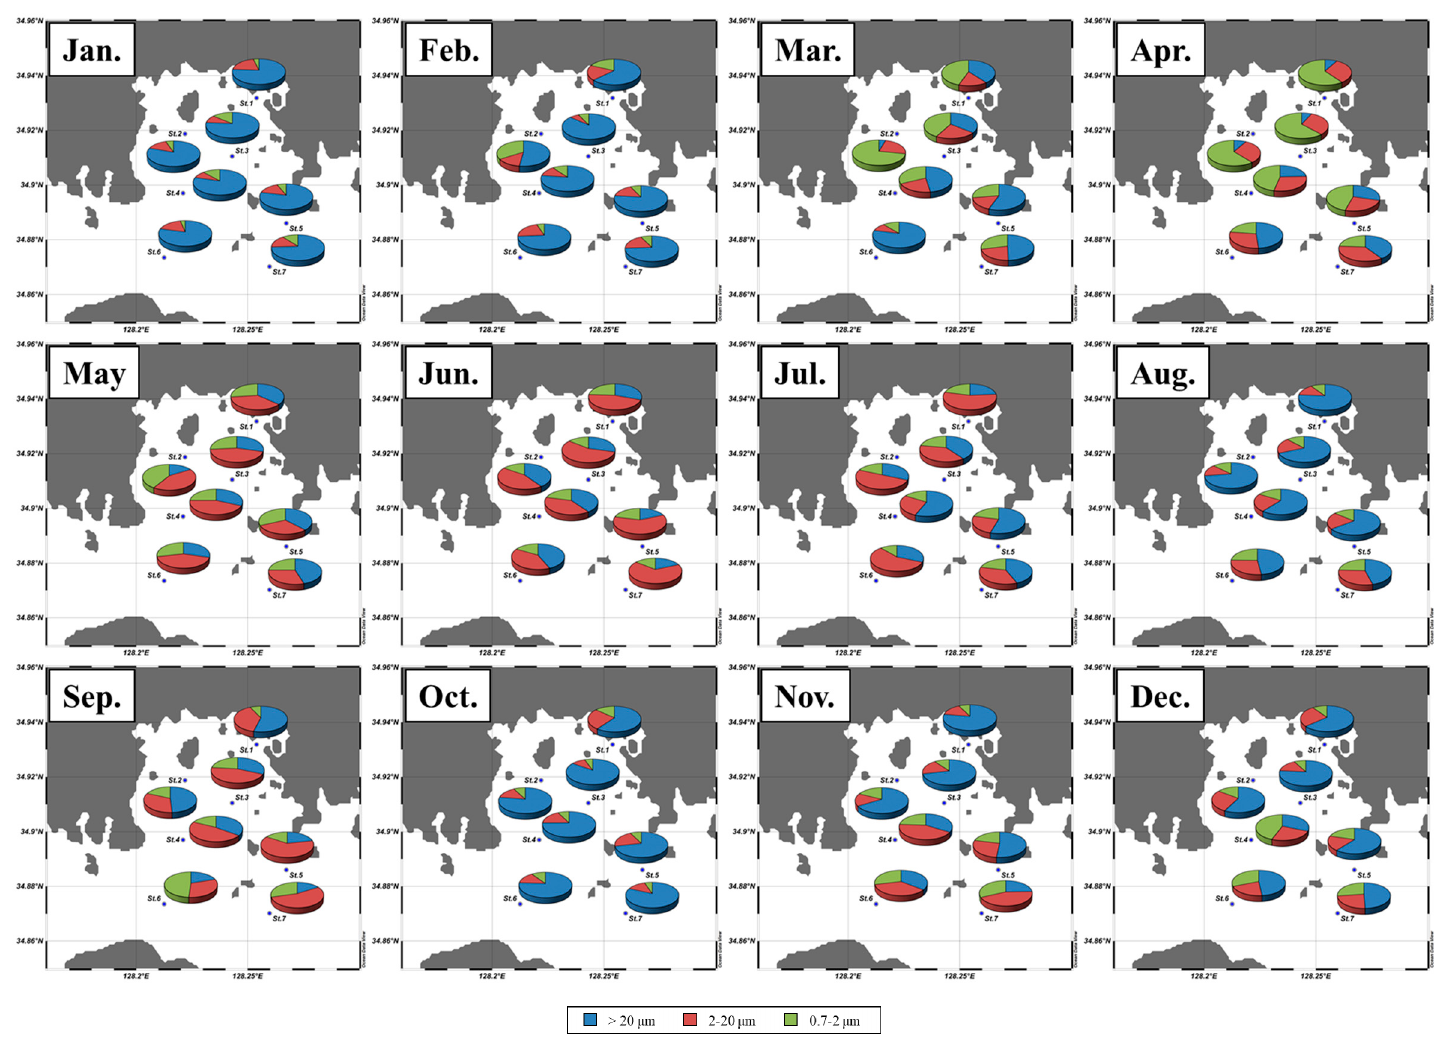
Figure 3. Di ff erent size compositions of chlorophyll a concentrations at the sampling stations in Jaran Bay.